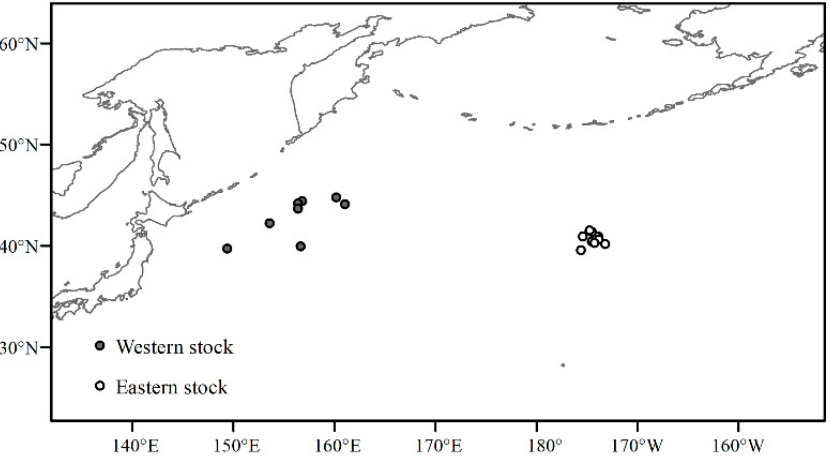
Figure 1. Map of North Pacific Ocean showing where the O. bartramii samples were collected. Table 1. Details of the O. bartramii sampling.